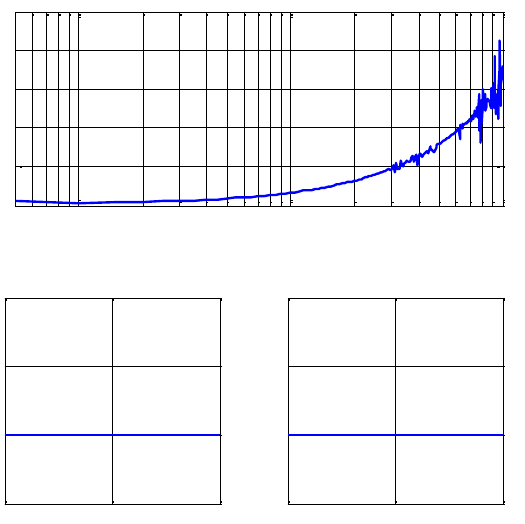
Figure 10: Spectrums of Y 2 in top, and the extracted resistance R 2 and capacitor C 2 in bottom.